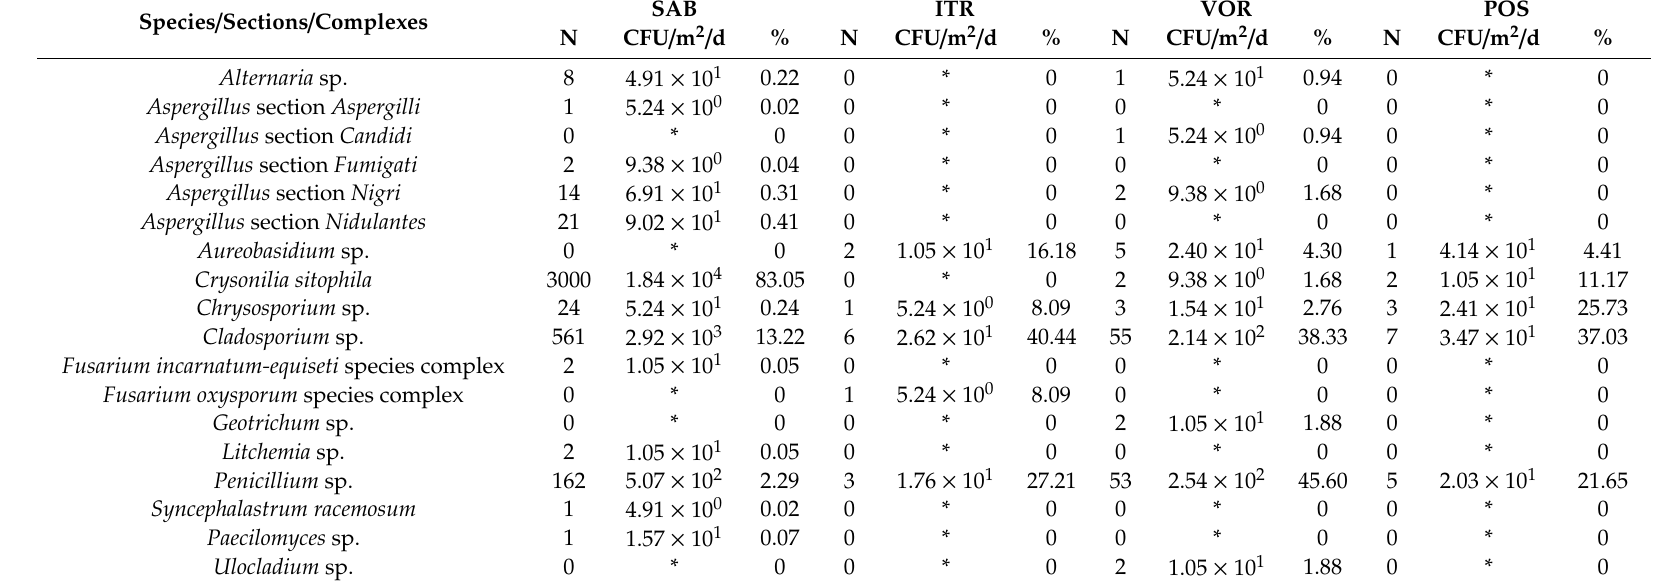
Table 5. Fungal species found on azole-screening